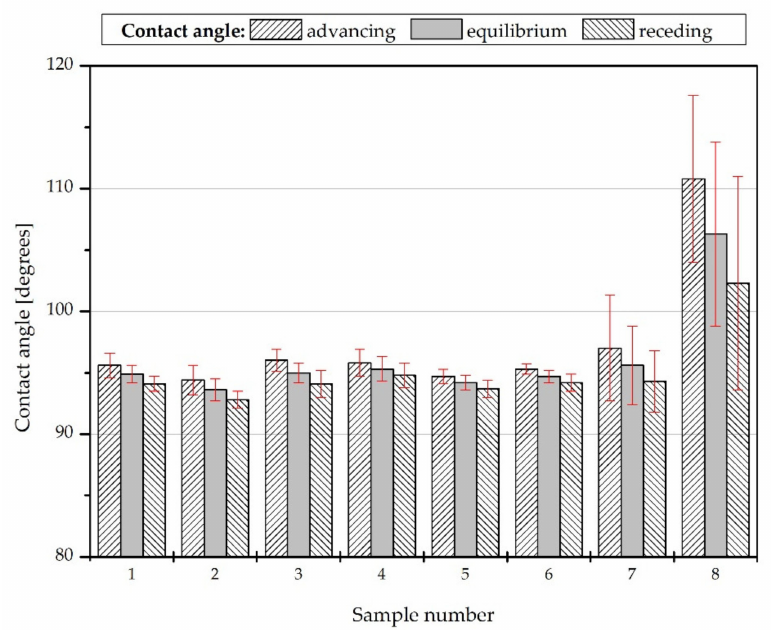
Figure 6. Water wettability of the obtained coatings. The highest WCA, equal to 106.3 ± 7.5 degrees, can be observed in the case of sample #8. As shown in Figure 7, this surface is also characterized by the largest contact angle hysteresis (8.5 ± 4.1 degrees) and the smallest surface free energy (21.2 ± 3.8 mJ/m 2 ). This results from the method of applying the coating; the layer with the largest thickness and heterogeneity was obtained, which confirms its roughness parameters and the surface height map. The high standard deviations of the contact angles, contact angles hysteresis, and surface free energies indicate a wide physical and chemical heterogeneity of surfaces #7 and #8.